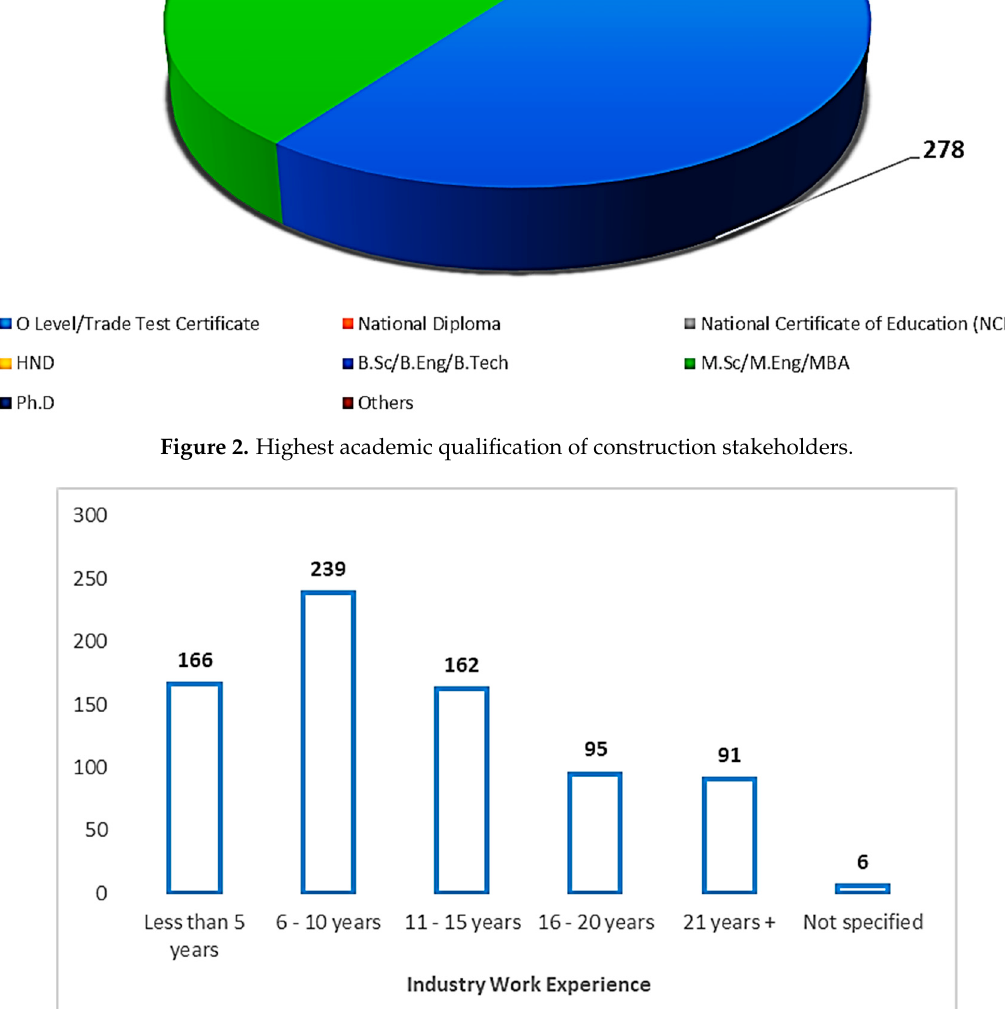
Figure 3. Industry work experience of the construction stakeholders.